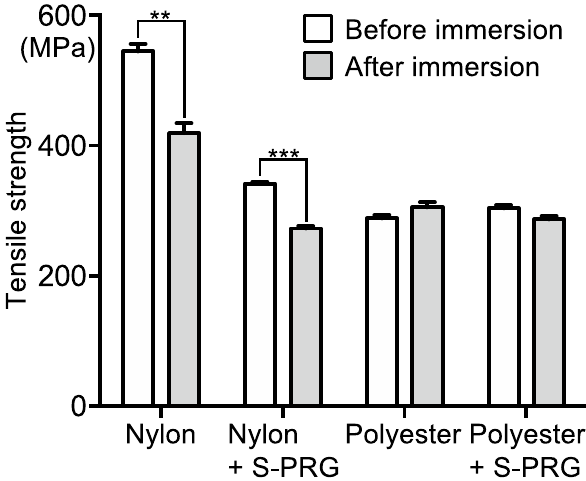
Figure 3. Tensile strength of monofilaments before and after immersion in water. Significant differences were determined using a chi-square test. ** P < 0.01, *** P < 0.001 between the